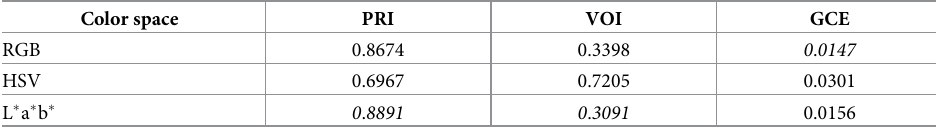
Table 5. Average PRI, VOI, and GCE values of the resulting images.